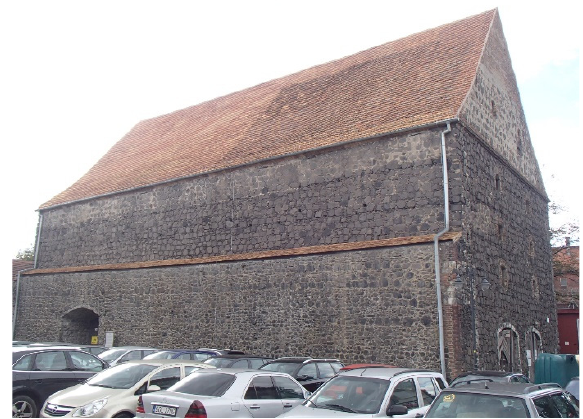
Figure 13. The Salt House elevation view.